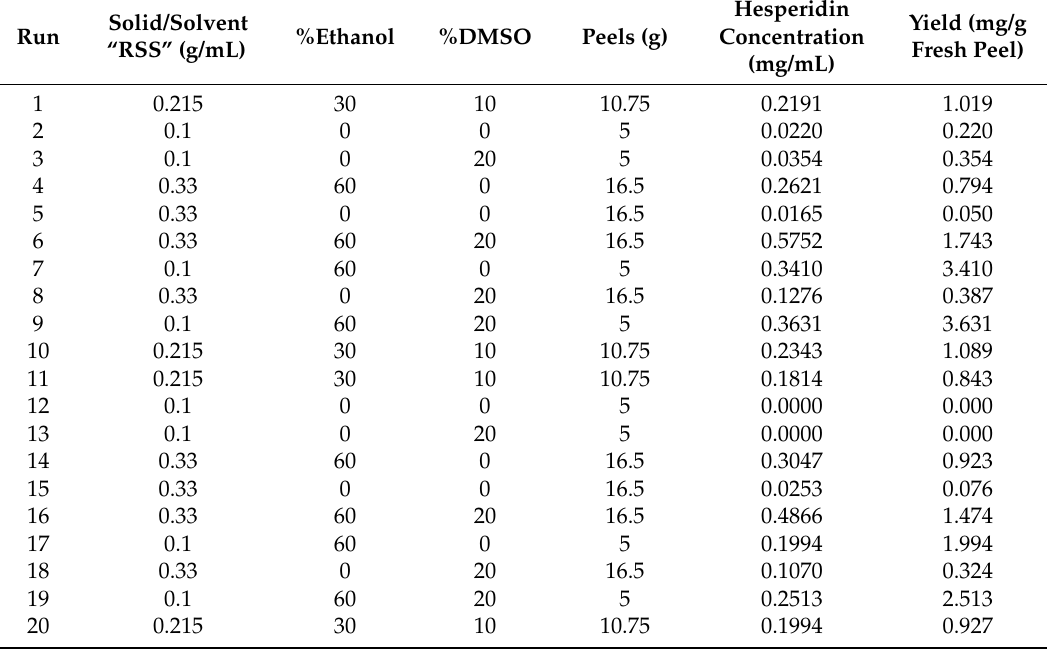
Figure 3. Extraction yield for a solid-to-solvent ratio (SSR) of 0.1 g/mL ( A ) and 0.33 g/mL ( B ). a Significant factors in the variance analysis ( p < 0.05). Table 2. Concentration of hesperidin in the extracts obtained at a laboratory scale.